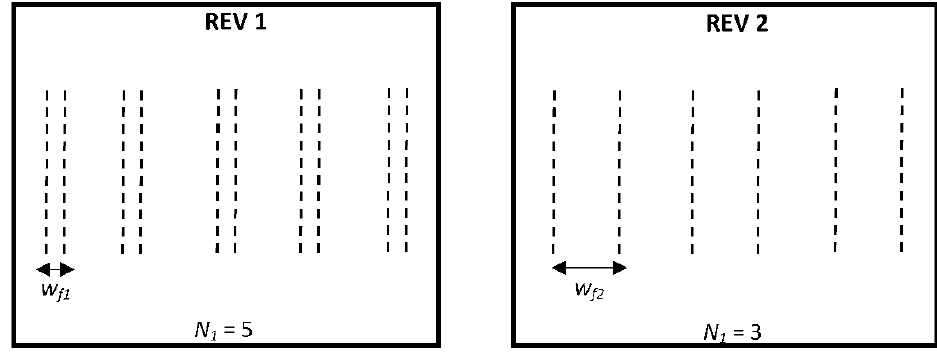
Figure A3. Two equal REV’s with different numbers of natural fractures .